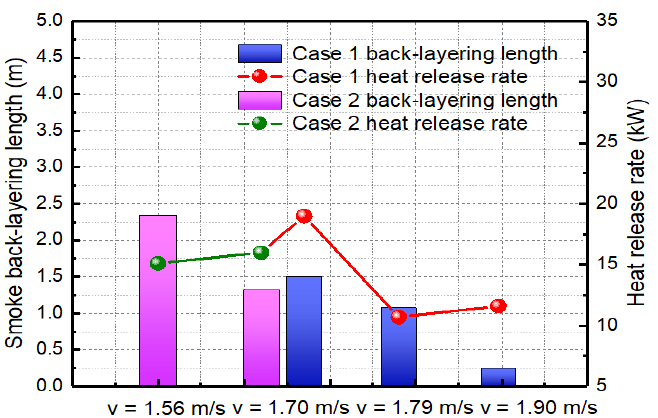
Figure 6. Back-layering length in the ventilation network with a diagonal branch.